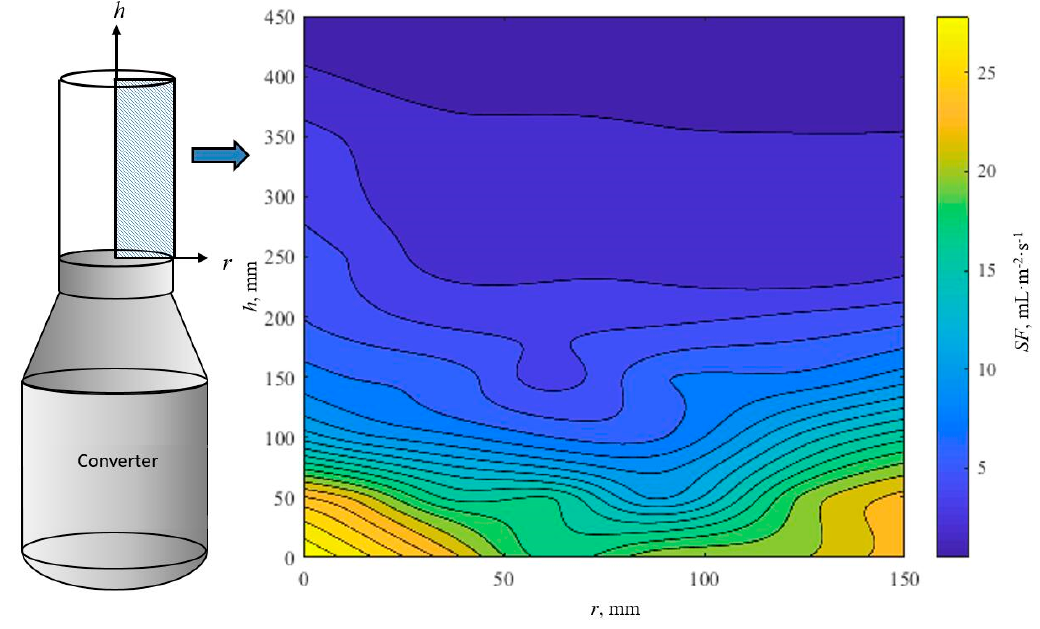
Figure 10. Splashing distribution above the furnace mouth.